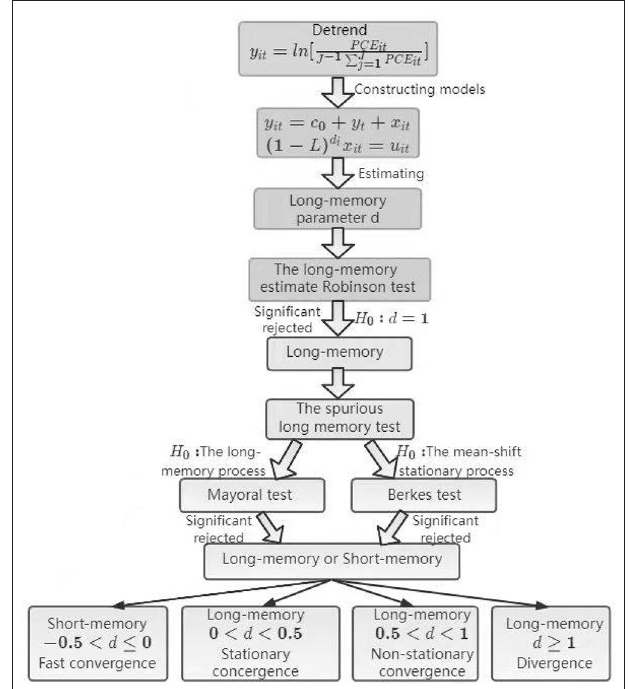
FIGURE 1 | A flow diagram for testing the long-memory of ecological